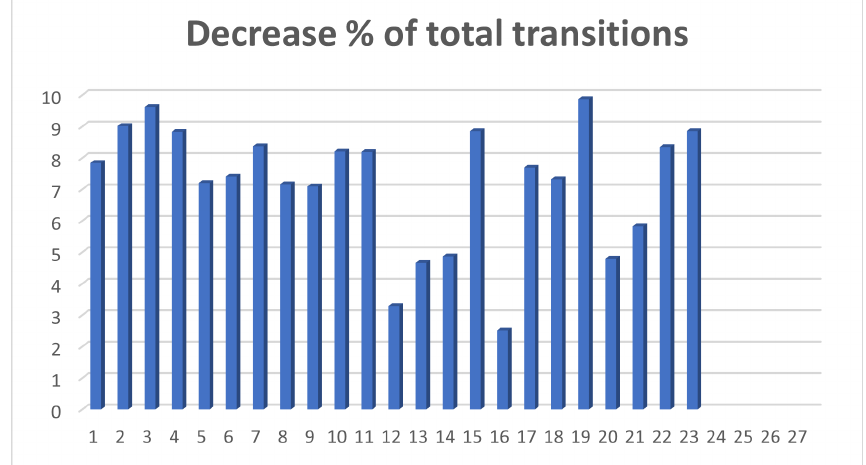
Figure 6. Bar chart of % reduction of 0-0, 0-1, 1-0, and 1-1 transitions after the